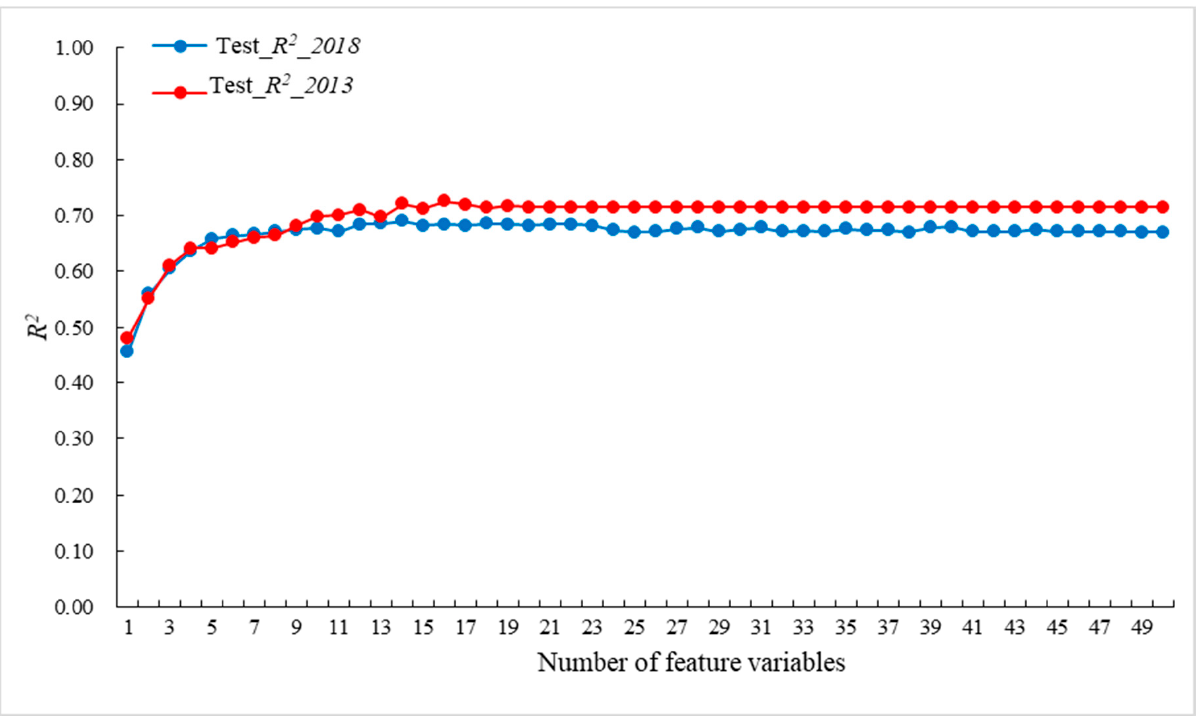
Figure 3. Importance of the input features derived from the random forest model using 80% of samples as training data in 2018. Note: NDSI_12 is normalized difference index calculated for band 1 and band 2 of MODIS, NLFI_12 is the fusion night light index based on the normalized difference index.